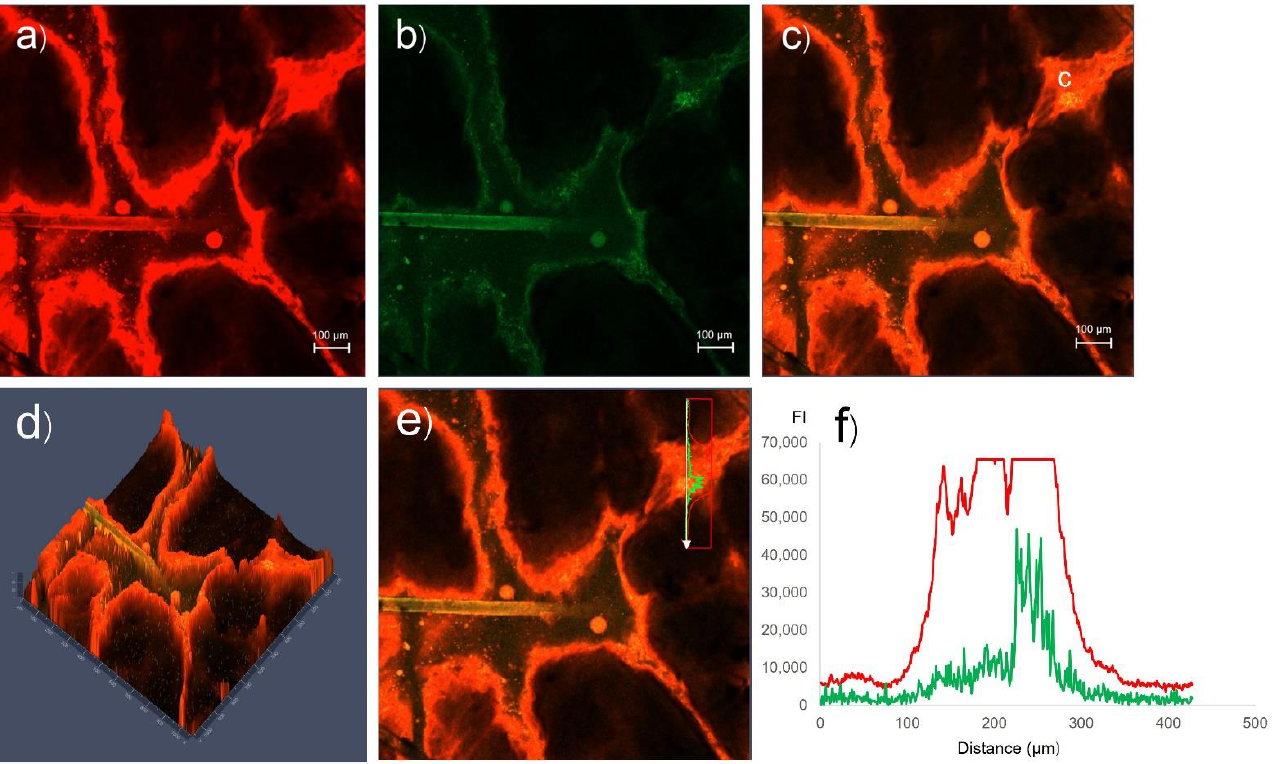
Figure 3. CLSM images of the intercluster pathway of pig skin treated with rhodamine B base-loaded NBD-PE probed microemulsions at 30 min: ( a ) red fluorescence from rhodamine B base; ( b ) green fluorescence from NBD-PE; and ( c ) merged image of ( a ) and ( b ) (c = canyons); ( d ) 3D image of ( c ); ( e ) region used for fluorescence intensity determination (white arrow); ( f ) fluorescence intensity profiles of red fluorescence (red line) and green fluorescence (green line) from ( e ). The scale bar represents 100 µm.